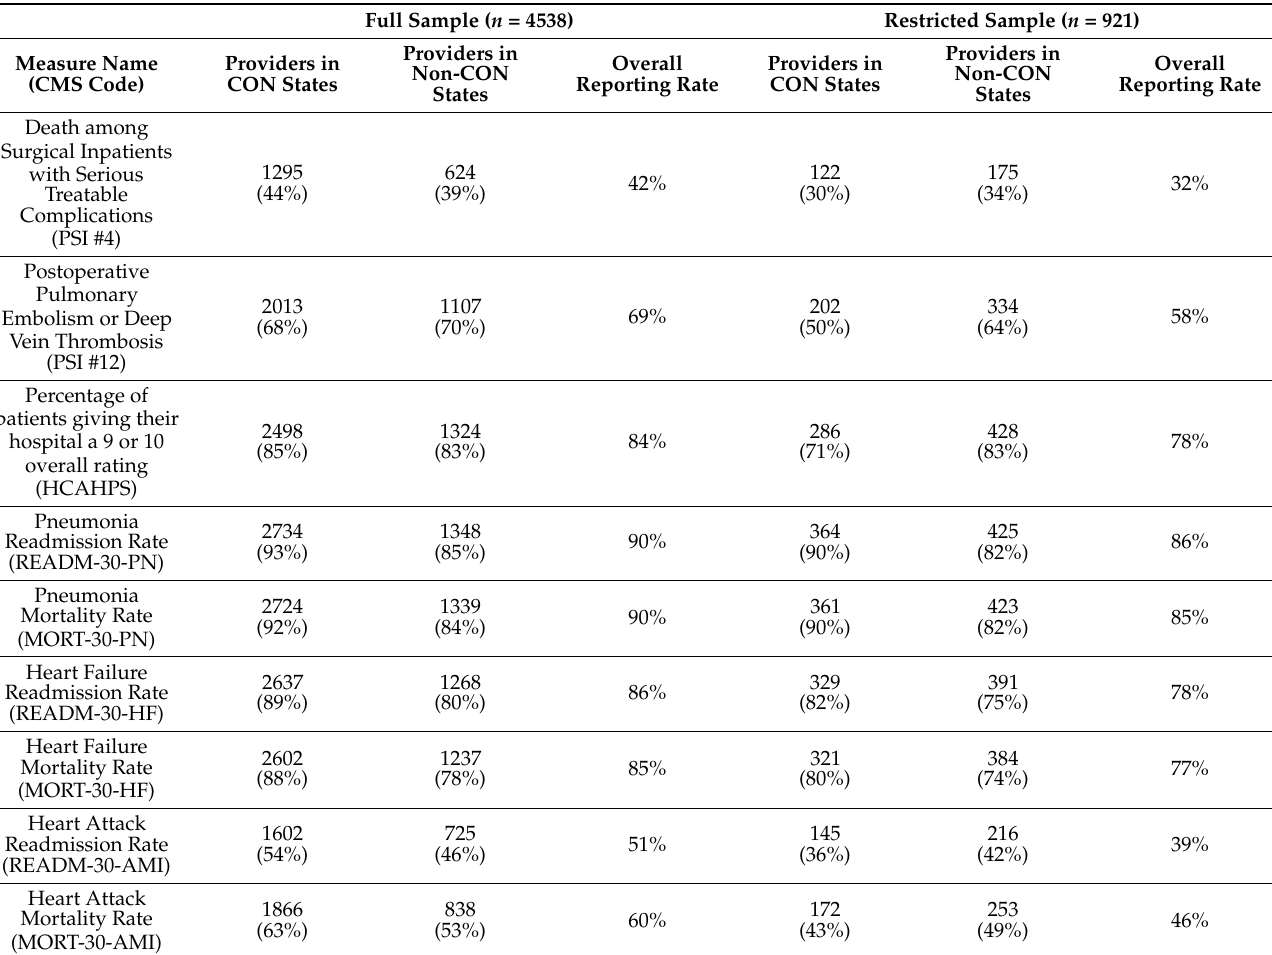
Table 1. Reporting rates for hospital quality metrics in the full sample and the restricted sample